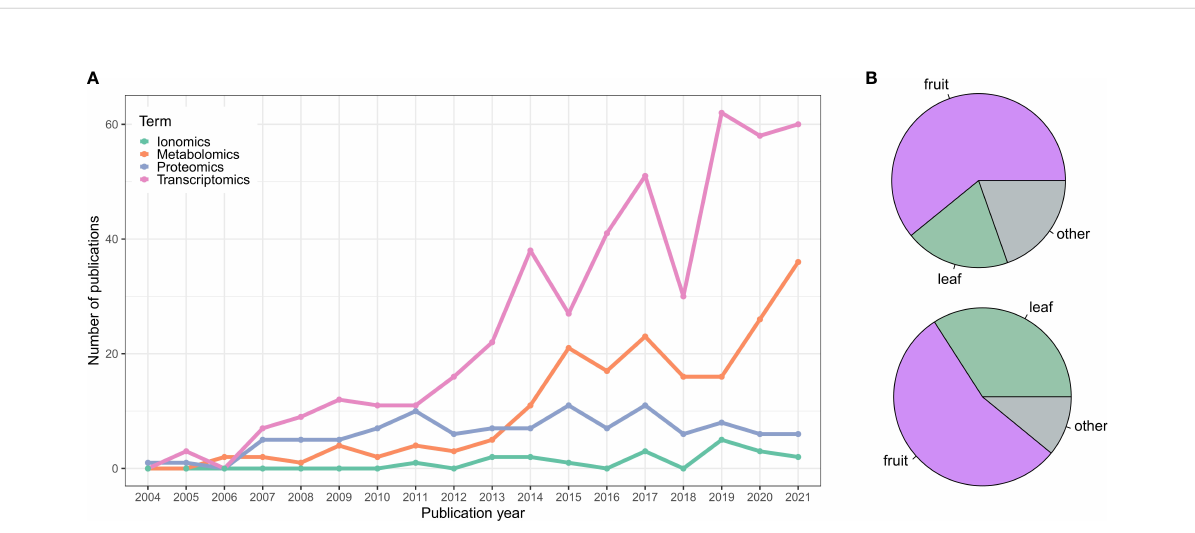
FIGURE 1 (A) Publication trend of grapevine omics studies. Data was collected from NCBI using different queries and keywords for each category to be as comprehensive as possible and retrieve most of the works. Transcriptomics query: 1) RNA-Seq (excluding microarray data):